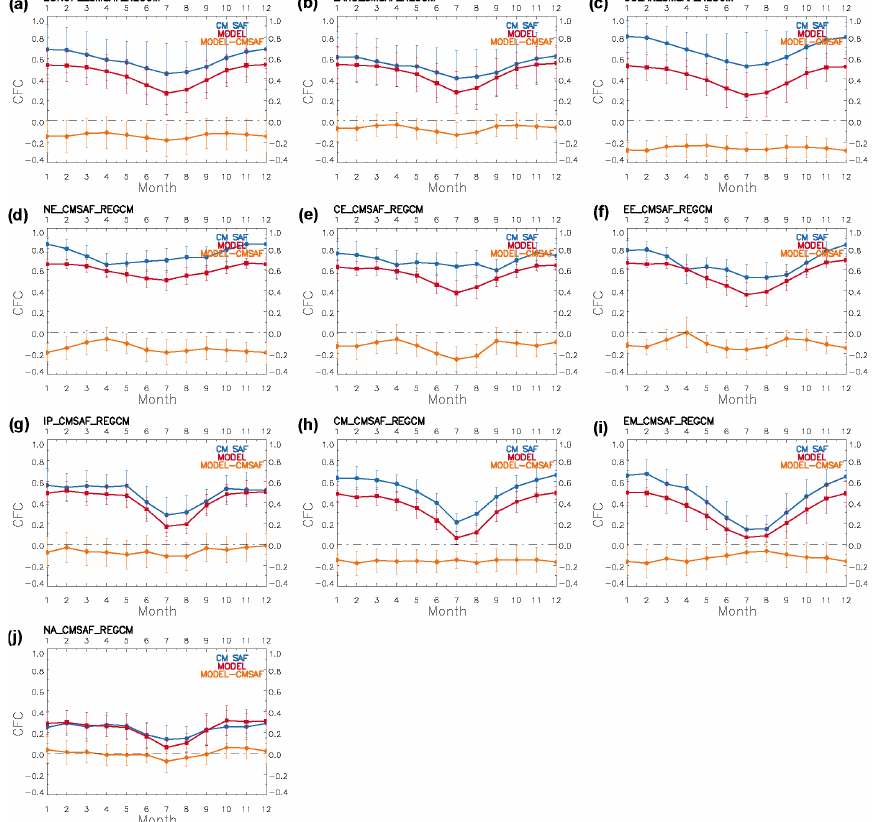
Figure 6. The same as Fig. 3 but for RegCM4 and CM SAF